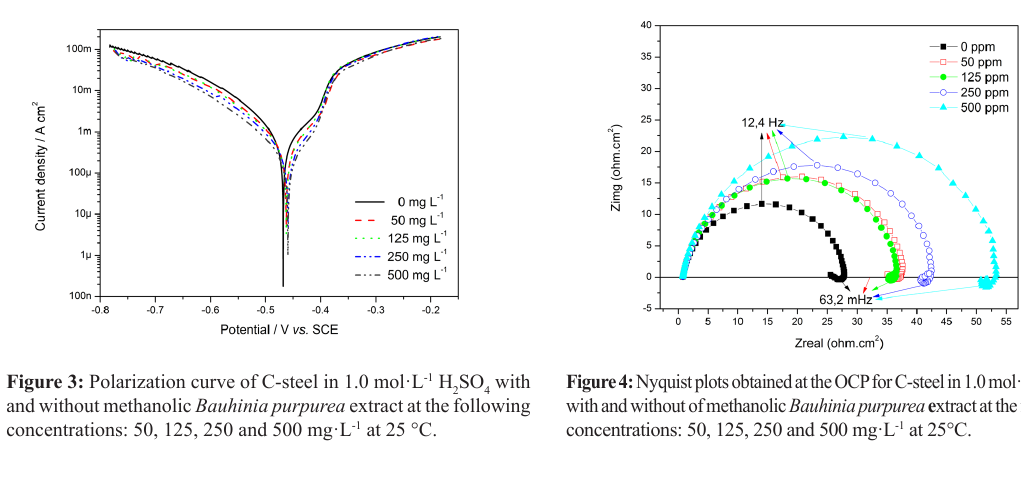
SO with and without methanolic Bauhinia purpurea 2 4